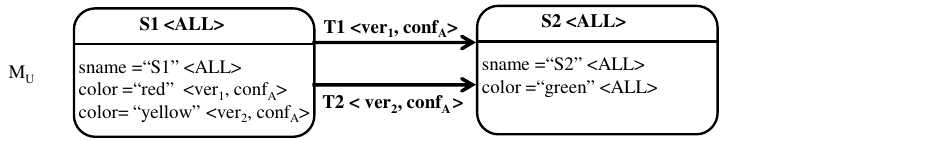
Figure 22. Conventional representation of M U as an annotated state transition